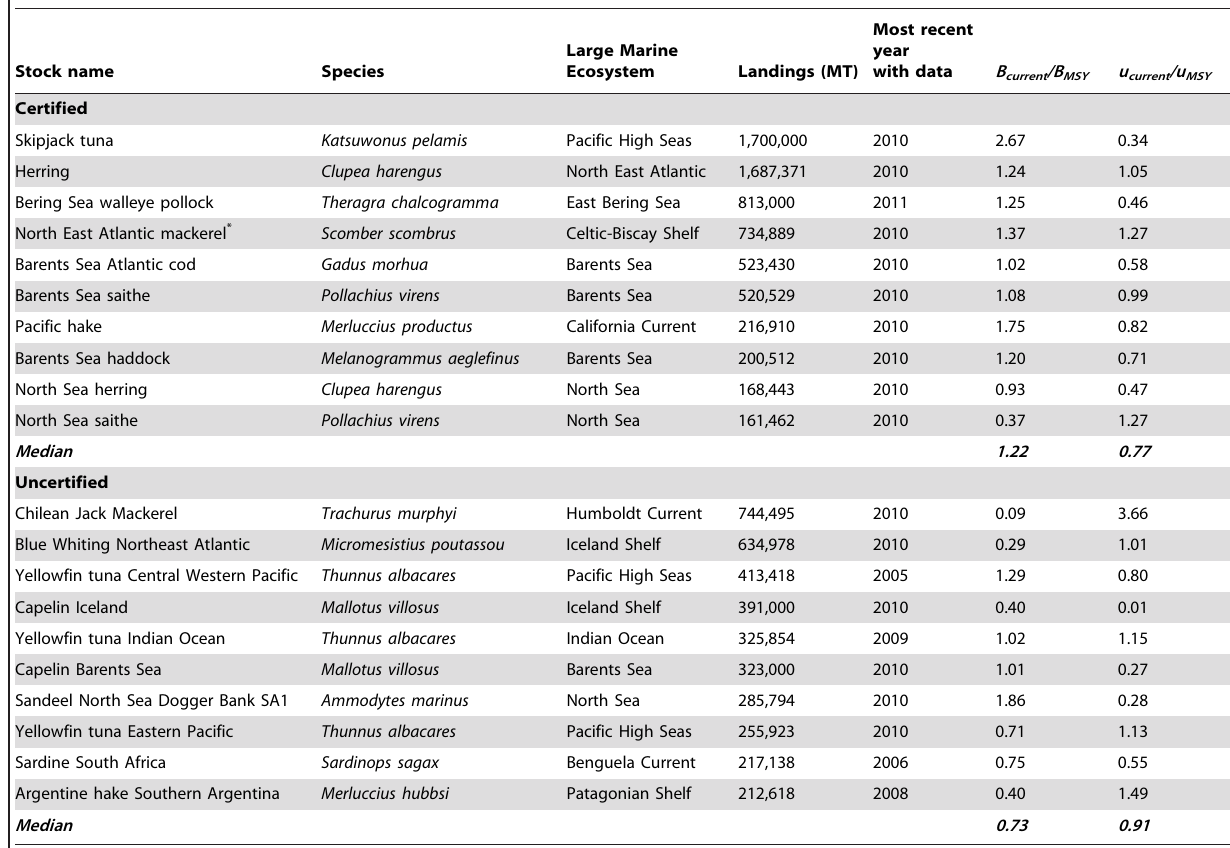
Table 1. Stock status by landings.